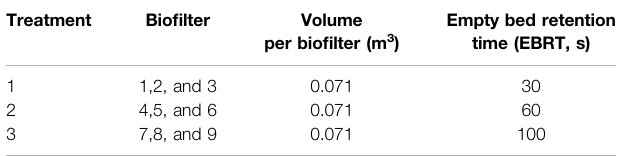
TABLE 1 | Experimental performance of bio fi